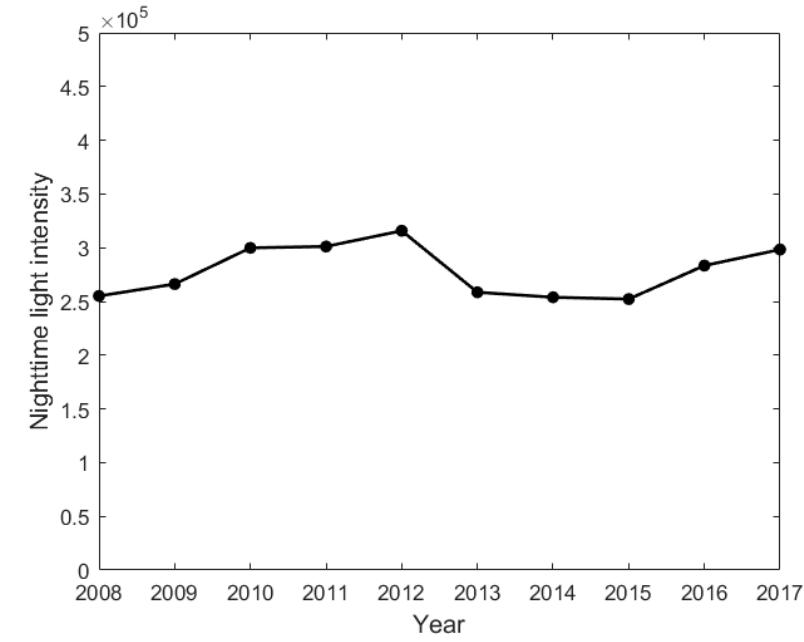
Figure 3. Total DN value of nighttime light in Beijing after processing.